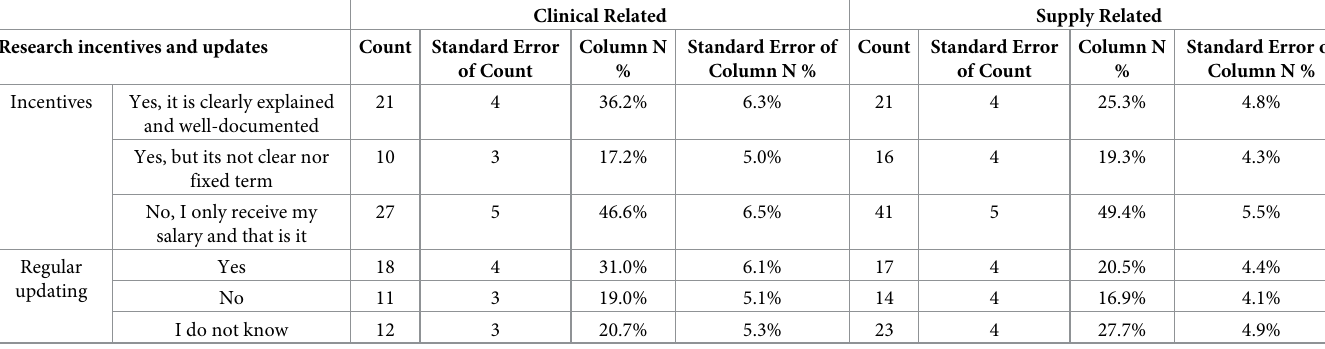
Table 6. Relation between specialty fields and research incentives, and whether they are regularly updated in RMS. Clinical Related Supply